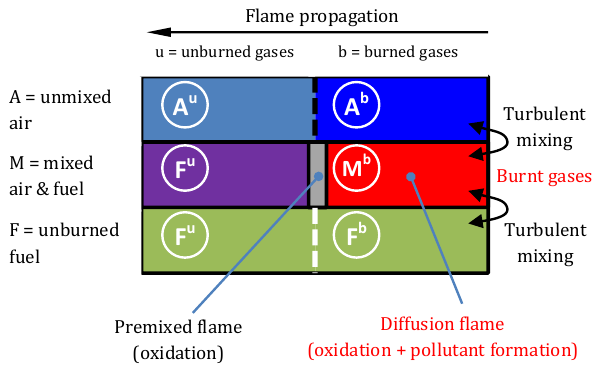
Fig. 2. Schematic of the ECFM-3Z model computational cell